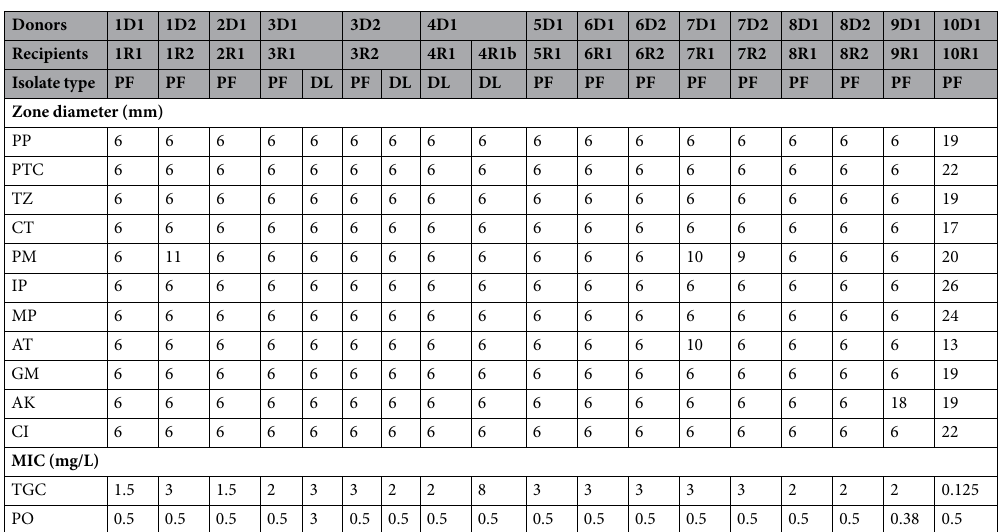
Table 2. Antibiotic susceptibility profiles of the 18 clinical isolates of A . baumannii [Zone diameter (mm) and MIC (ug/mL)]. ※ PP: Piperacillin, PTC: Piperacillin/Tazobactam, TZ: Ceftazidime, CT: